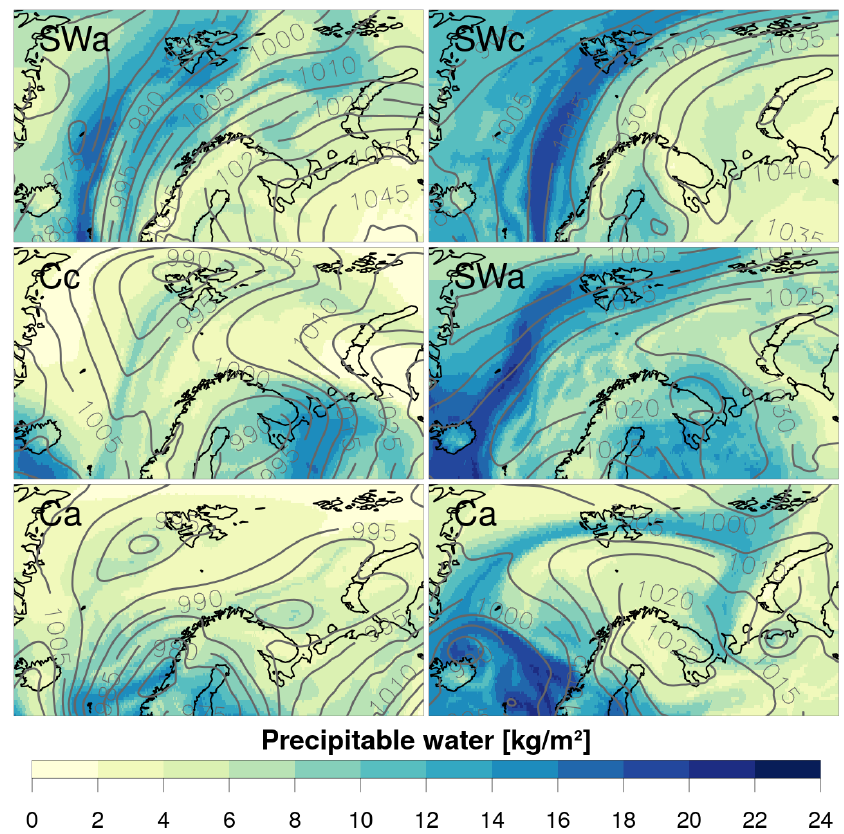
Figure 14. Precipitable water (colours) and sea level pressure (contours) for the top three precipitation events in the 1971–2000 ( left ) and 2071–2100 ( right ) climate simulations. The labels in the top left corner denote the corresponding weather